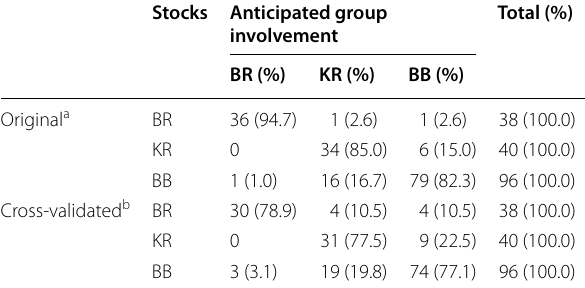
a 87.33% of unique grouped cases appropriately categorized b 77.83% of cross-validated grouped cases accurately